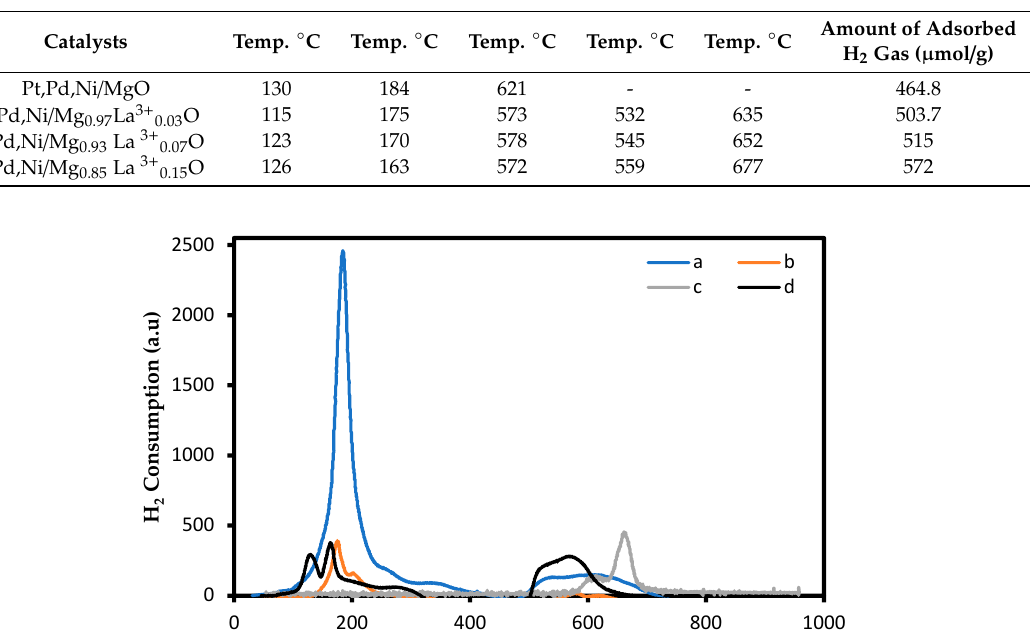
Table 2. H 2 -TPR values of the di ff erent catalysts.